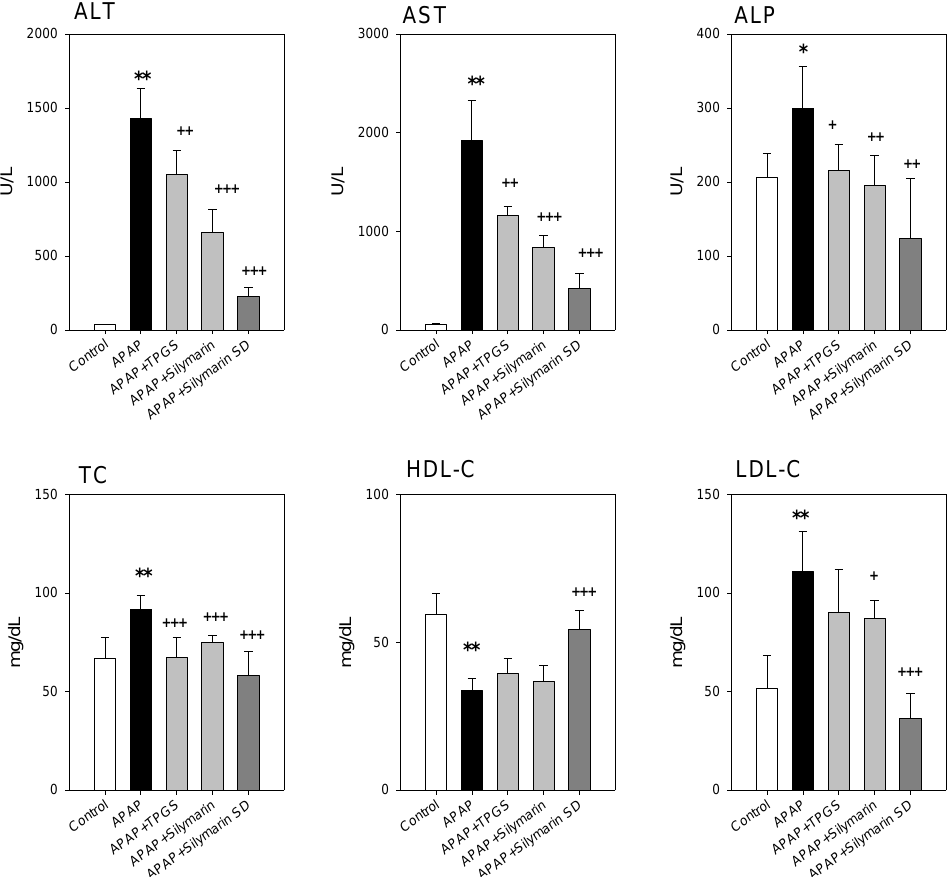
Figure 7. Alanine aminotransferase (ALT), aspartate aminotransferase (AST), alkaline phosphatase (ALP), total cholesterol (TC), high-density lipoprotein-cholesterol (HDL-C), and low-density lipoprotein-cholesterol levels (LDL-C) from control, acetaminophen (APAP)-induced hepatotoxic rat (APAP), APAP-induced hepatotoxic rats treated with TPGS 50 mg/kg (APAP+TPGS), silymarin (20 mg/kg as silybin) (APAP+Silymarin), and silymarin-SD (20 mg/kg as silybin) (APAP+Silymarin-SD). Treatment followed the dosing schedule in Figure 1. Each data represents mean ± standard deviation of four rats per group. * p < 0.05, and ** p < 0.01, compared with silymarin group; + p < 0.05, ++ p < 0.01, and +++ p < 0.001, compared with APAP group.